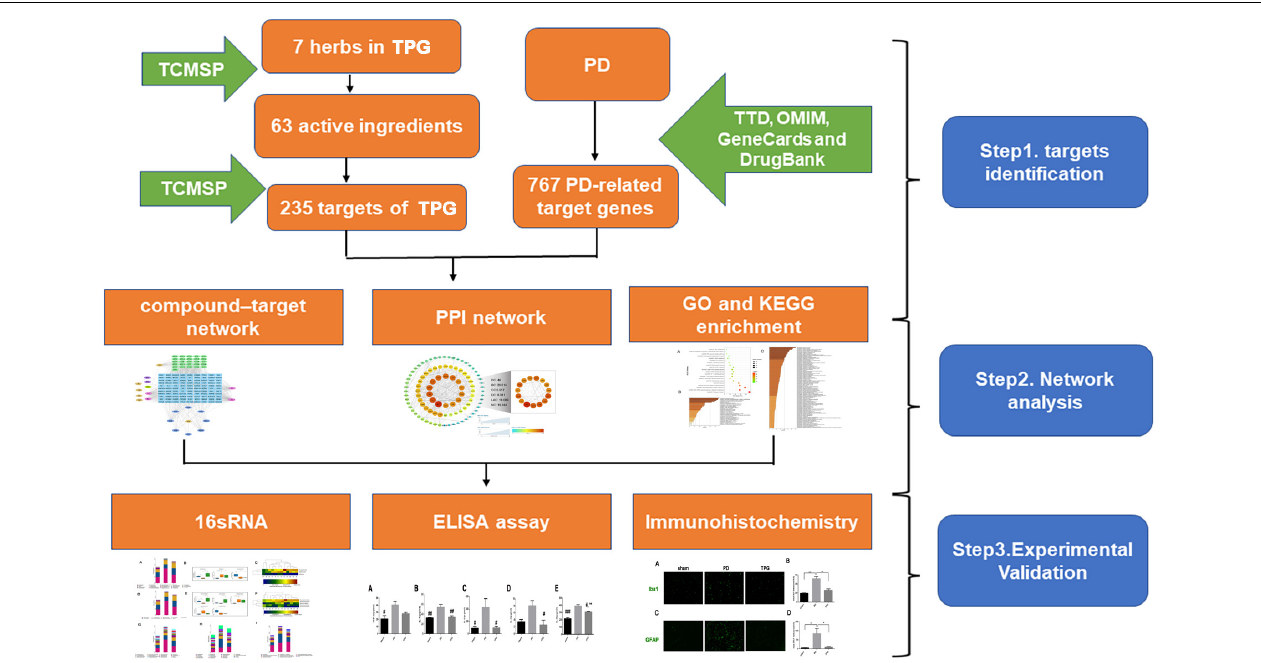
FIGURE 1 | The technical strategy of this study.